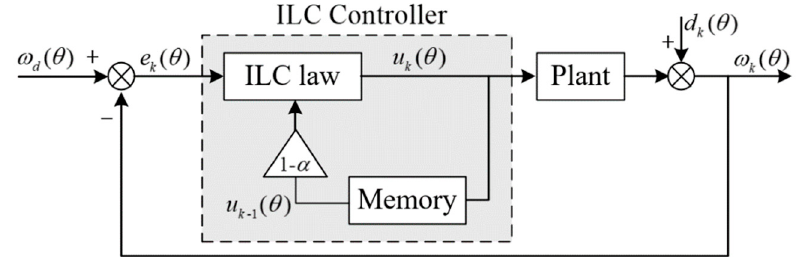
Figure 2. Block diagram of improved ILC.